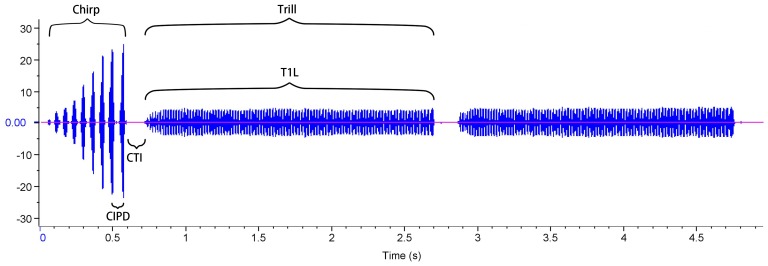
The courtship call of T. commodus.Each phrase consists of a single, amplitude-modulated chirp, followed by a variable number of trills (the phrase in the figure has two trills). We measured: dominant frequency (DF), chirp pulse number (CPN), chirp inter-pulse duration (CIPD), chirp-trill interval (CTI), trill number (TN) and the length of the first trill (T1L). The vertical axis represents the amplitude of the sound produced.